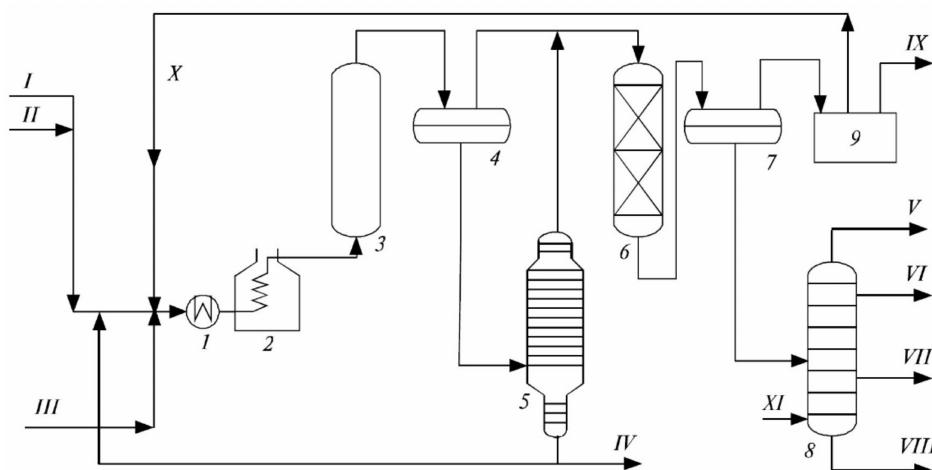
Figure 6. The flow chart of vacuum-residue thermal hydrocracking in adsorbent suspended-bed under VCC technology. 1—heat exchanger; 2—furnace; 3—reactor; 4—hot separator; 5—vacuum column; 6—2nd stage reactor (hydrocracking); 7—separator; 8—column; 9—gas treatment unit; I—stock; II—adsorbent; III—hydrogen; IV—residue (>520 ◦ C); V—gases C1–C4; VI—naphtha; VII—diesel fuel; VIII —vacuum gas oil; IX—hydrogen-sulfide-containing gas; X—hot hydrogen- containing gas; XI—water